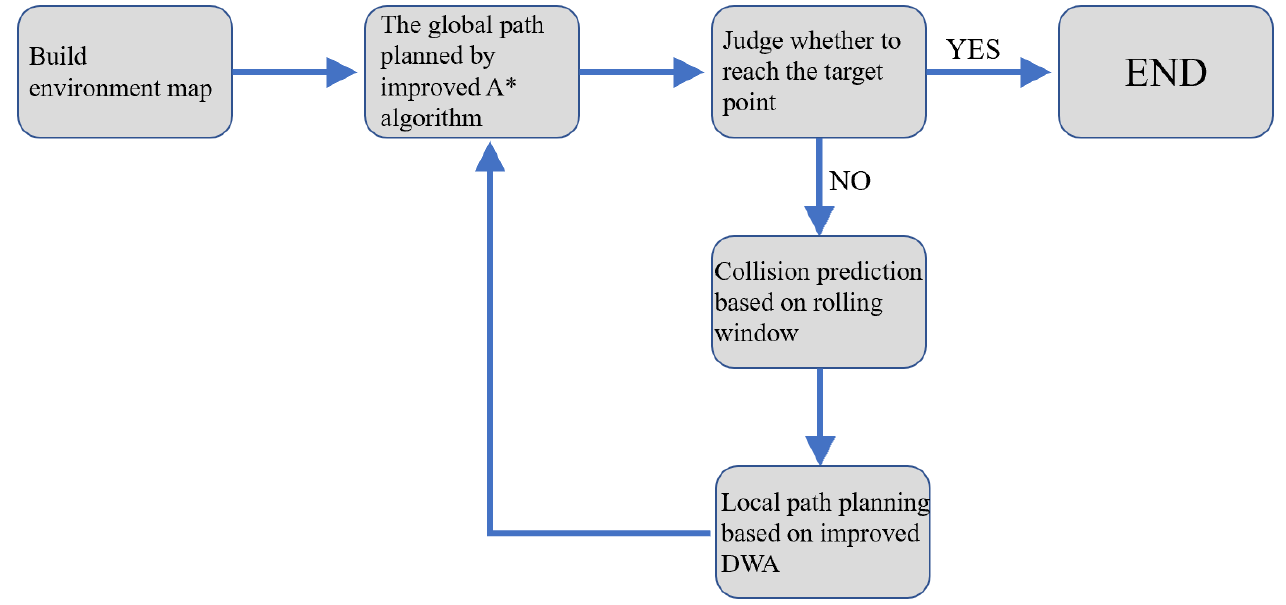
Figure 6. Process diagram of hybrid algorithm.